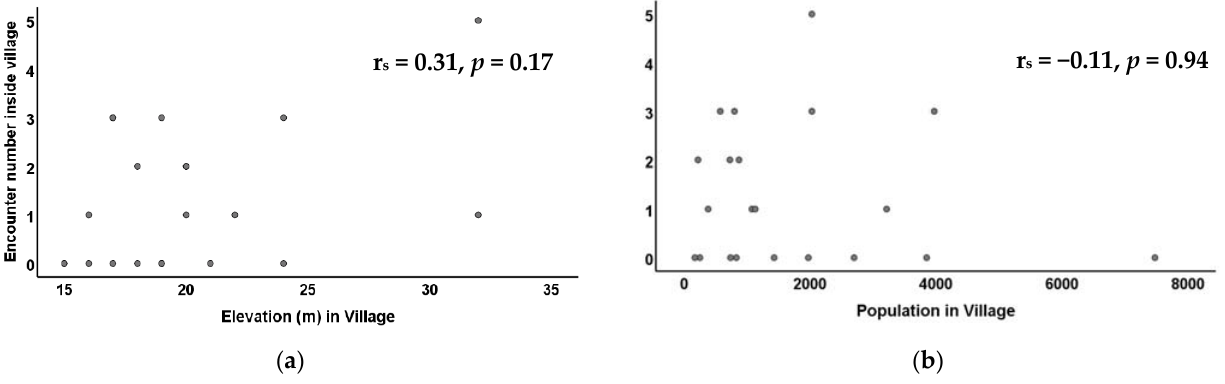
Figure 5. Relationships between encounter numbers and village ( a ) elevation and ( b ) population size.